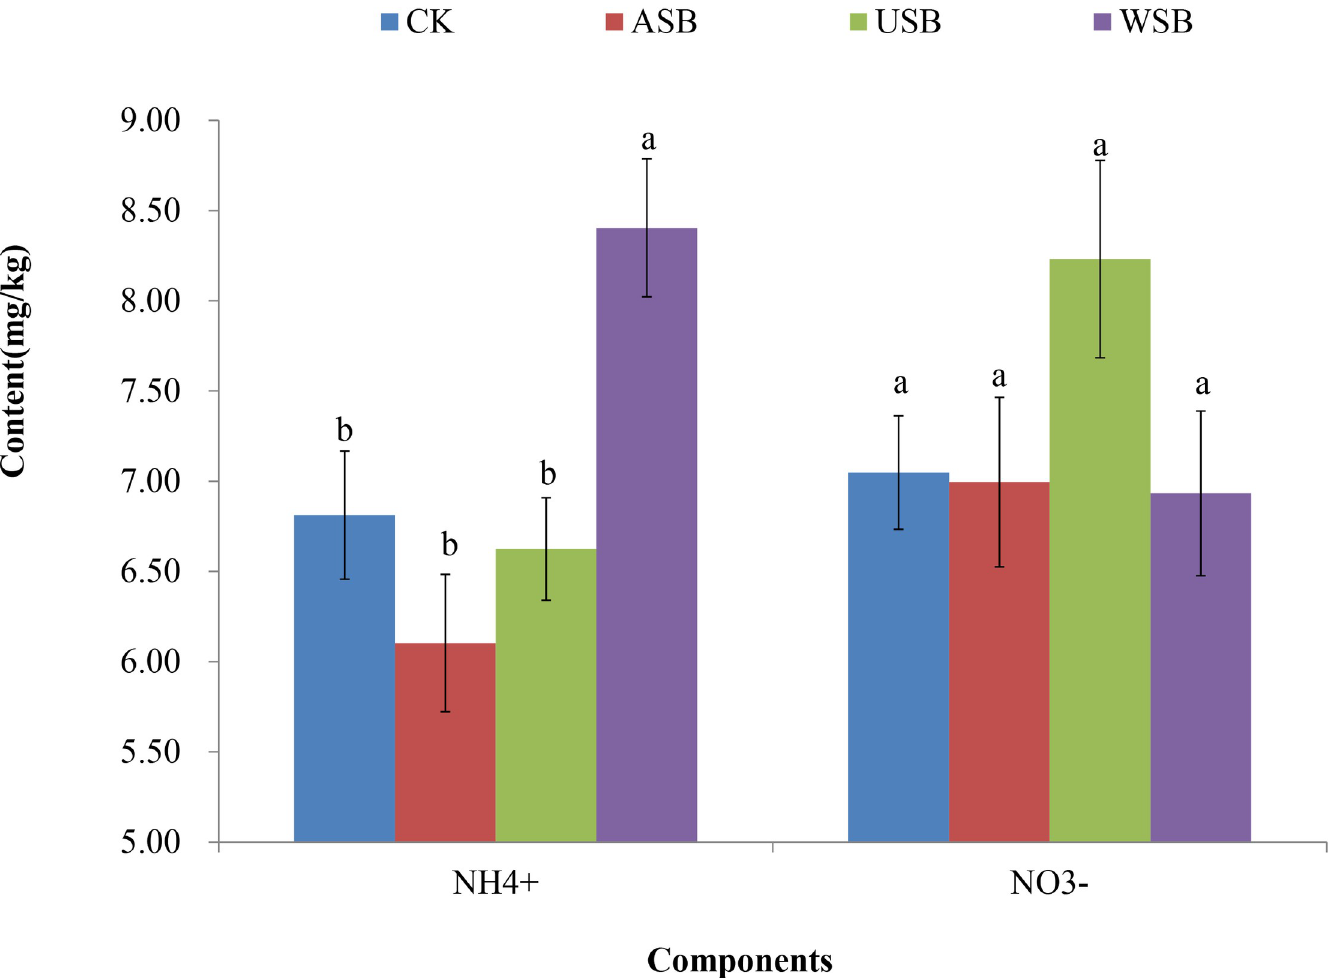
Fig 2. Contents of soil NHNH 4+ and NO 3- in consecutive soybean planting and covering treatments. NH 4+ and NO 3- were measured at the completion of the third application of the treatments. Error bar in each column represents ± standard error. Different lowercase letters indicate significant differences in the means of NH 4+ or NO 3- among different treatments as determined by the Duncan test (P < 0.05). CK, control; ASB, aboveground soybean parts; USB, underground soybean parts; WSB, whole soybean